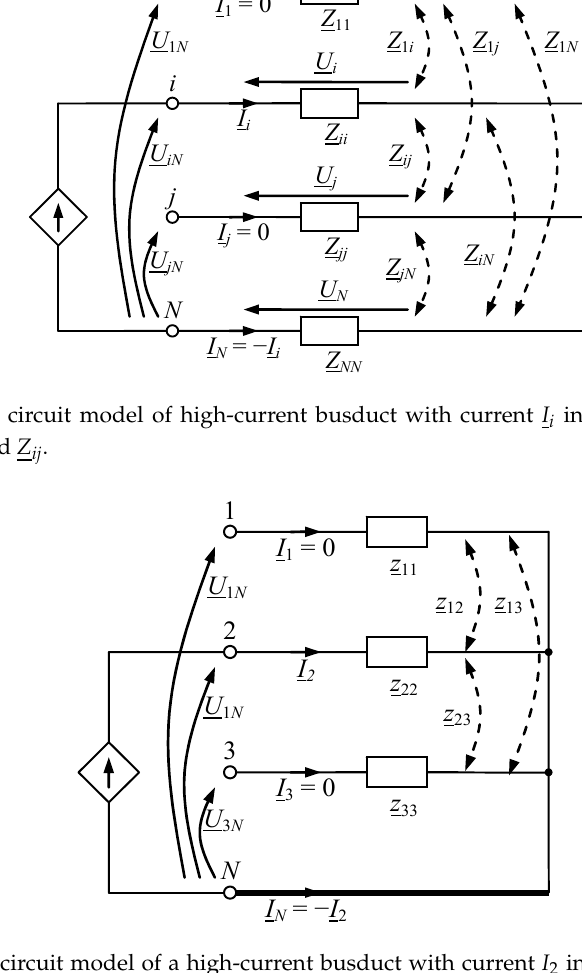
Figure 5. Electric circuit model of a high-current busduct with current I 2 in a closed loop 2 -N and reduced self-impedances z ii and mutual impedances z ij .